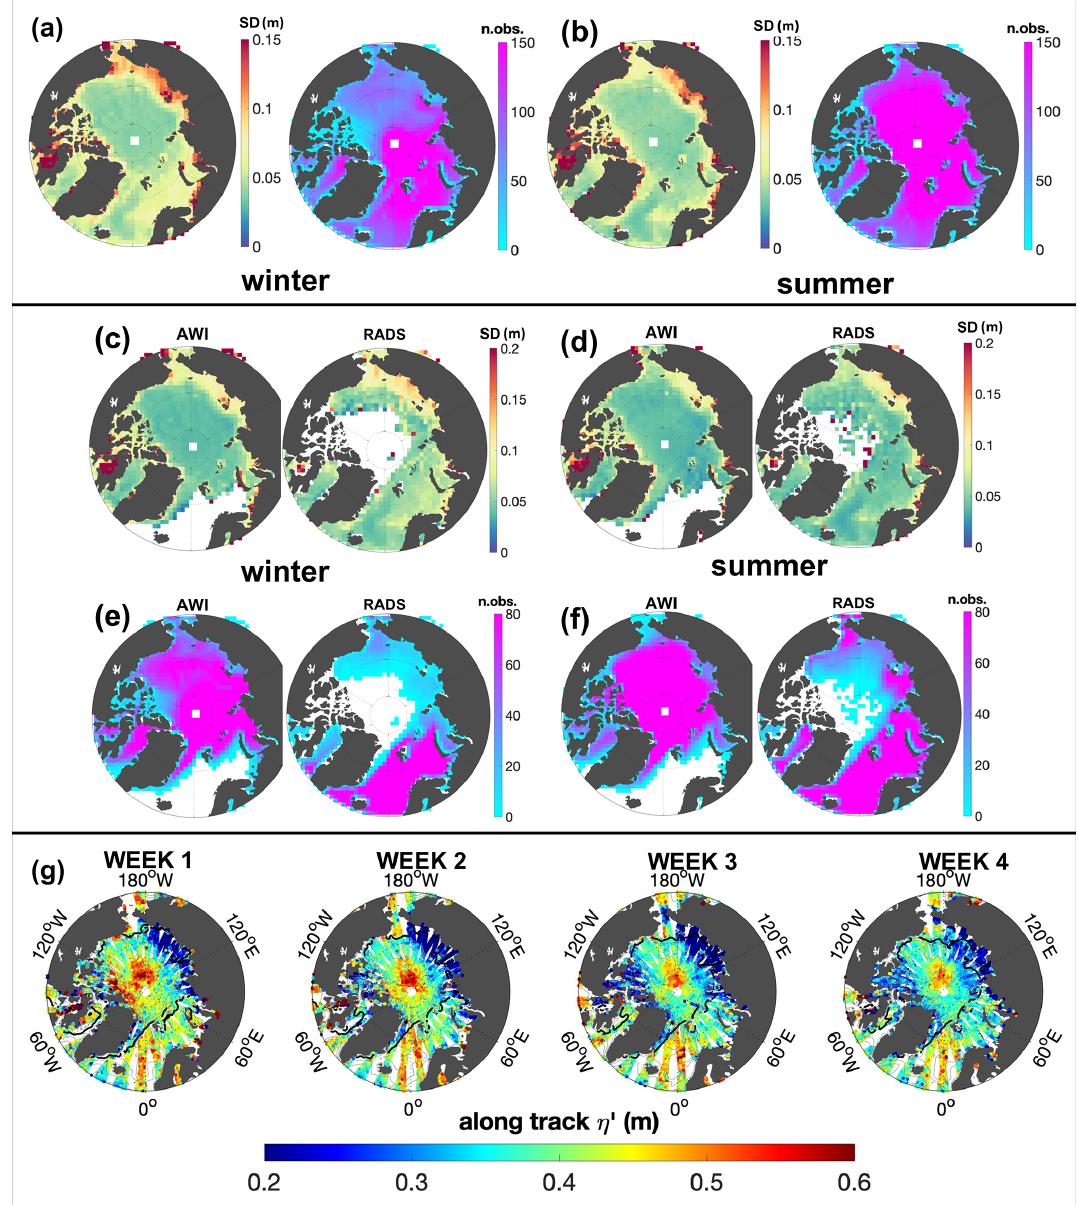
Figure 3. Average monthly statistics of the along-track η (cid:48) dataset over the ice-covered and ice-free Arctic Ocean in the period 2011–2020. Standard deviation (panels a left, b left, c, d ) and the number of observations per 100km 2 per month (panels a right, b right, e, f ) for the merged dataset (a, b) and separately the AWI and RADS datasets (c–f) are shown for the winter (October to April) and summer (May to September) seasons. (g) Example of weekly along-track data in the month of July 2015; the black solid line indicates the 15% sea ice concentration as derived from the OSI SAF ice concentration products. Note the different color scales of panels (a) and (b) with respect to panels (c) – (f)